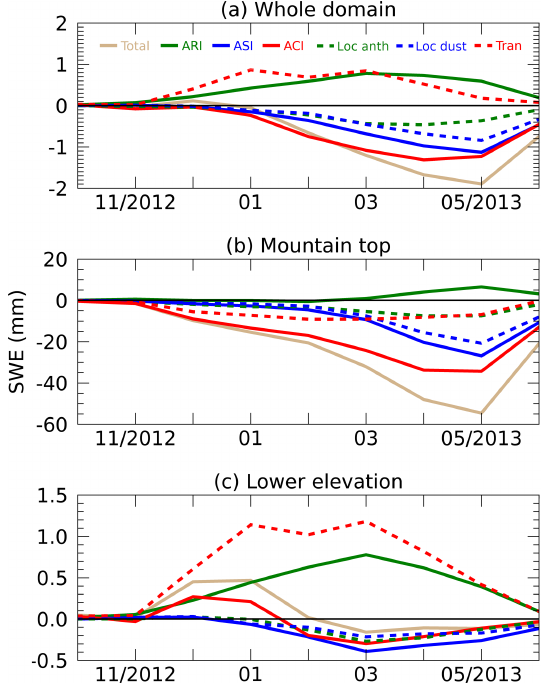
Figure 15. Same as Fig. 14, but for SWE (mm).